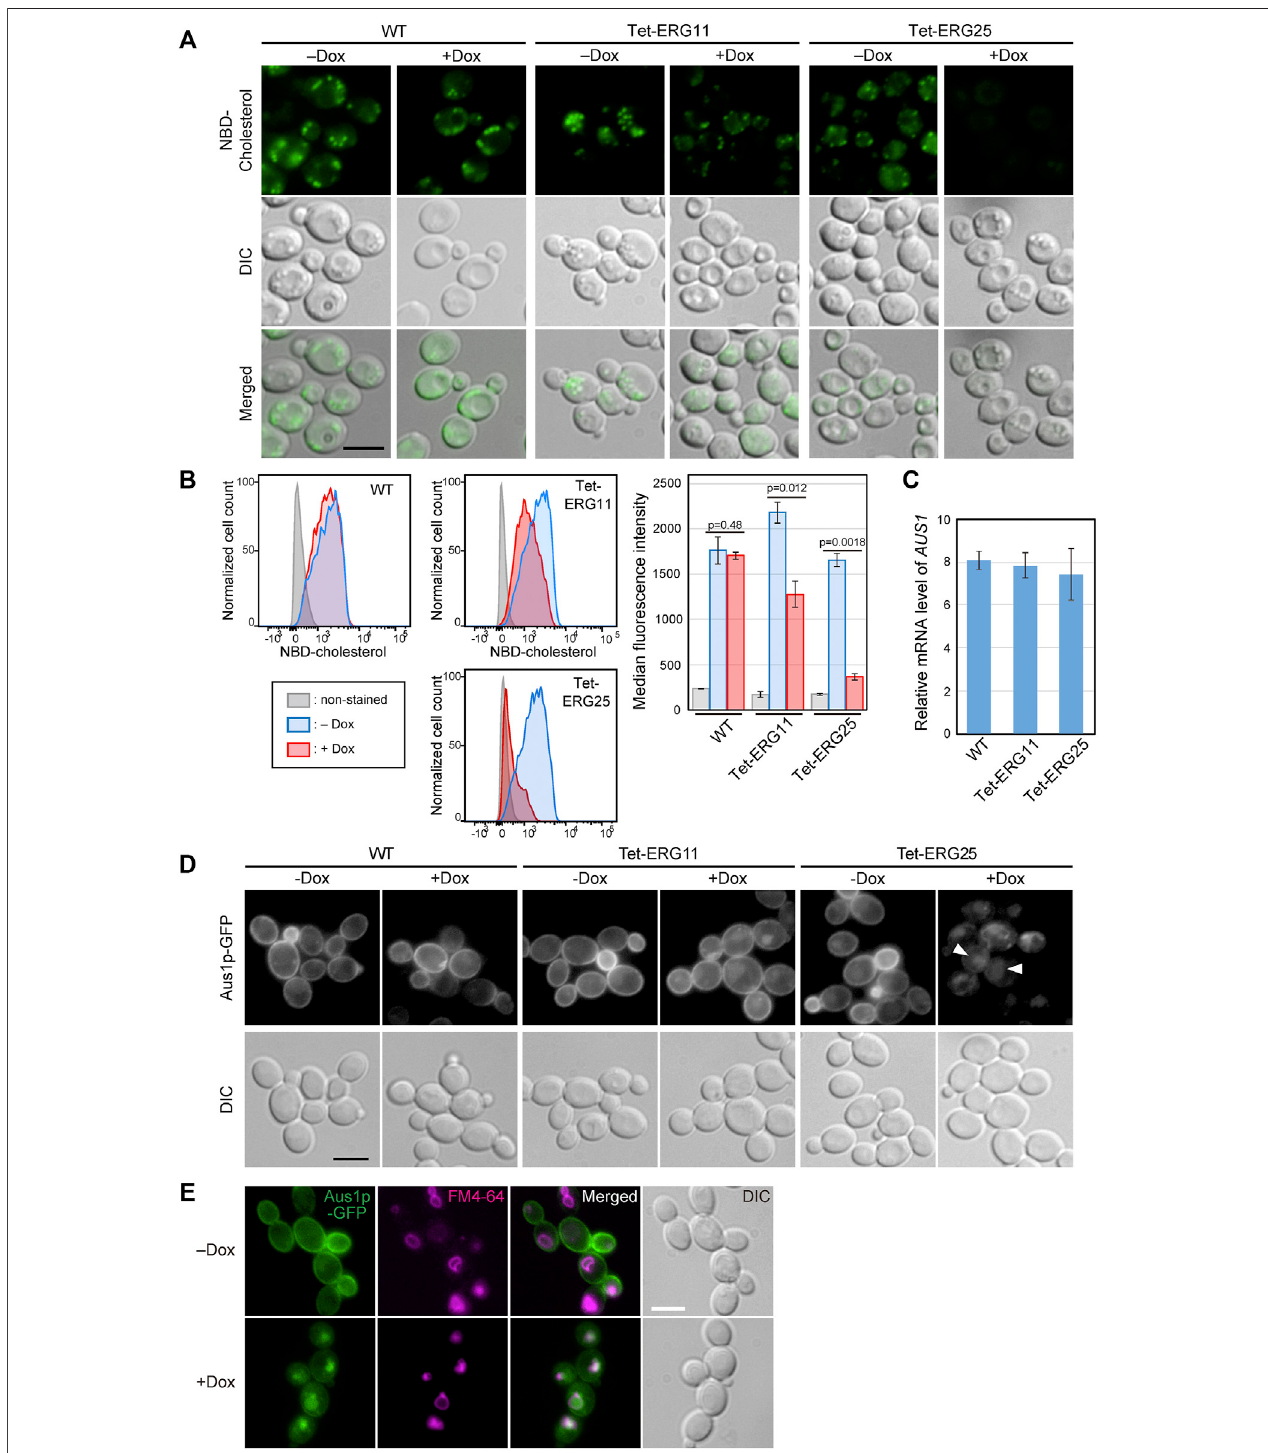
FIGURE2 | ERG25 knockdowncausesdefectsincholesteroluptakeandthelocalizationofAus1p. (A) Uptakeof fl uorescentcholesterolanalogues,NBD-cholesterol. Wild-type (HETS202), Tet-ERG11 and Tet-ERG25 cells were incubated with NBD-cholesterol in the presence (+Dox) or absence ( – Dox) of Dox for 17 h in minimal medium containing 10%(v/v) serum.After washing,the fl uorescenceofNBD-cholesteroltaken upintoeachcellwasobservedundera fl uorescencemicroscope. (B) Wild-type,Tet- ERG11andTet-ERG25cellswereincubatedasdescribedin (A) ,andthentreatedwithpropidiumiodide(PI).CellsnotstainedwithPIwerede fi nedaslivingcells,andthe fl uorescent intensity ofNBD-cholesterol taken up intothe cells was analyzed by fl owcytometry. Cells incubated without NBD-cholesterol served asunstained controls. Cell